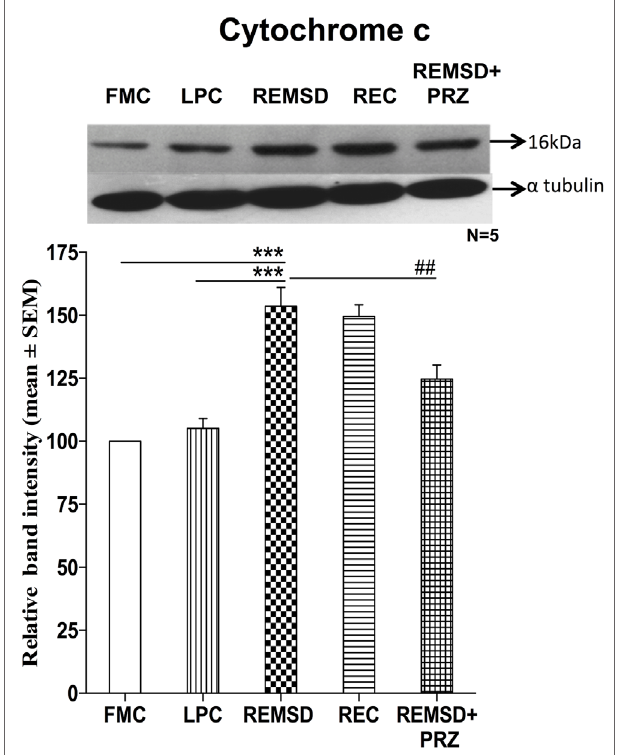
FigUre 3 | cytochrome c expression in the brain homogenate of rats under different conditions . Upper panel shows a representative Western blot of cytochrome c . Histogram in the lower panel shows percent changes in the mean ( ± SEM) band densities of the blots as compared to FMC taken as 100% in five sets of experiments. Abbreviations are as in the text. Significance levels are between the treatments of connecting horizontal bars; *** p < 0.001 and ## p < 0.01, * as compared to FMC and # as compared to